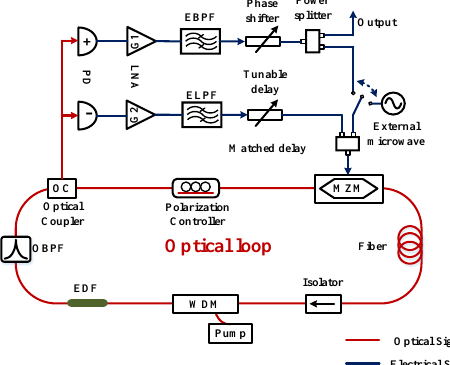
Figure 5. The schematic diagram of the COEO based on optical power feedforward technique. EDF: erbium doped fiber. WDM: wavelength division multiplex. OBPF: optical band-pass filter. MZM: Mach-Zehnder modulator. PD: photodetector. LNA: low noise amplifier. EBPF: electric band-pass filter. ELPF: electric low pass filter. Reprinted with permission from Ref. [38], OSA, 2018 .